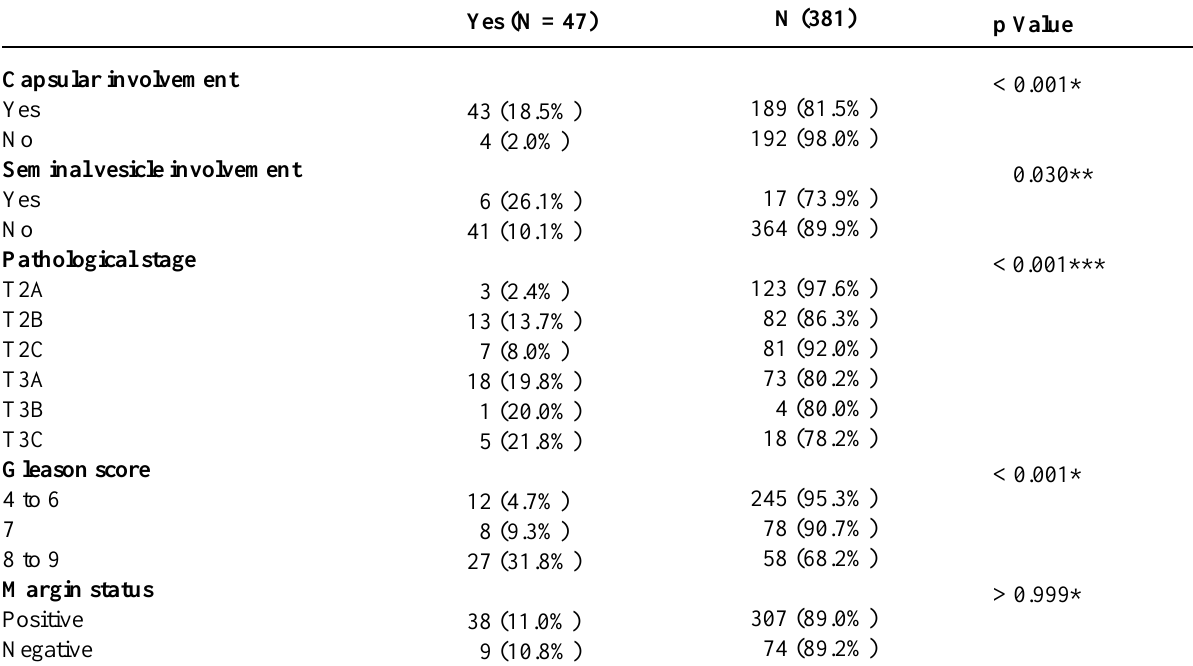
Table 2 – Postoperative variables according to the presence of microvascular invasion .